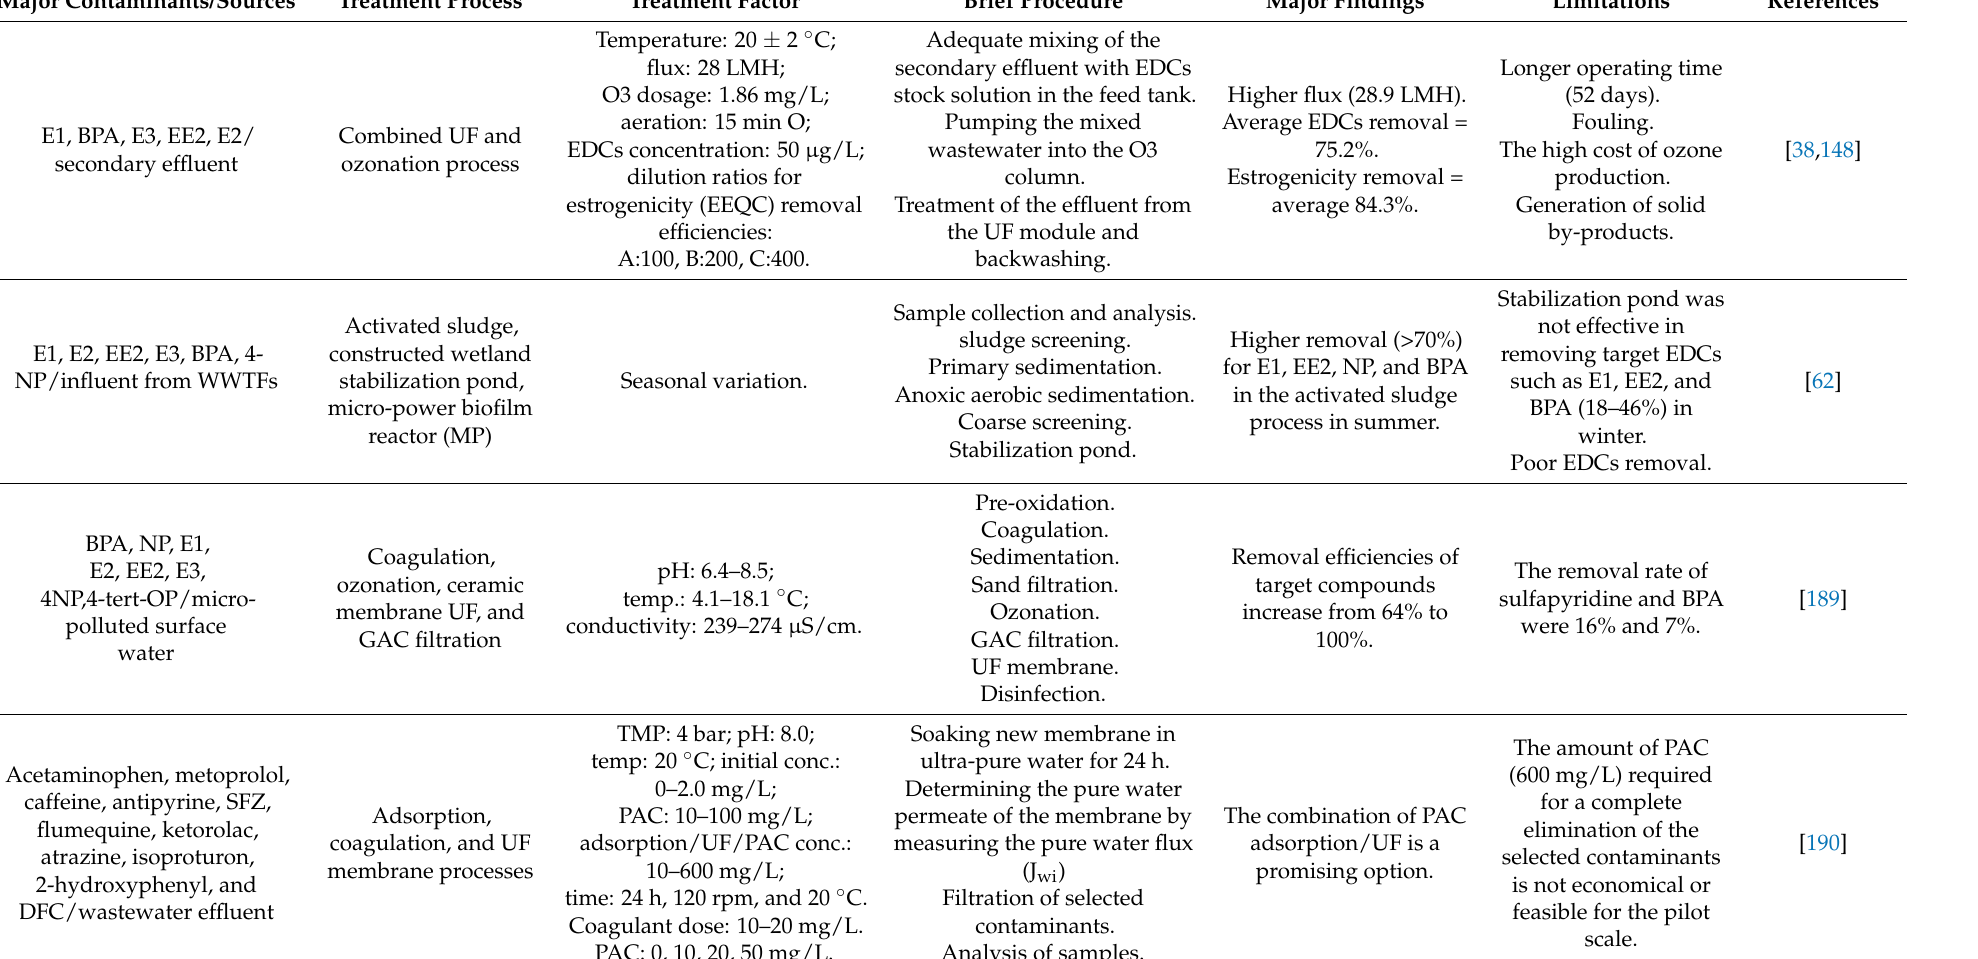
Table 7. Removals of some EDCs using hybrid